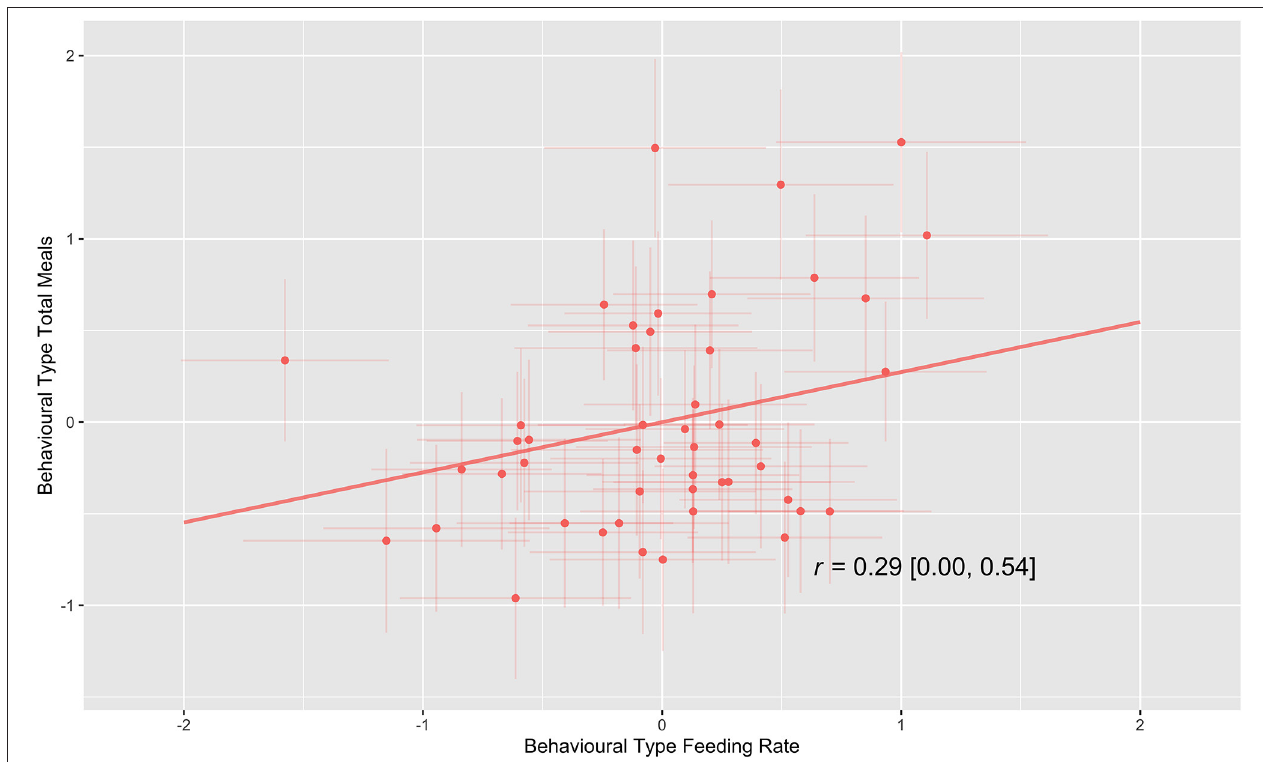
FIGURE 3 | Visual representation of the line of best fit of the among-individual correlation (r) between feeding rate behavioral type and total meals behavioral type. Posterior means and 95% credible intervals of point estimates for each calf are